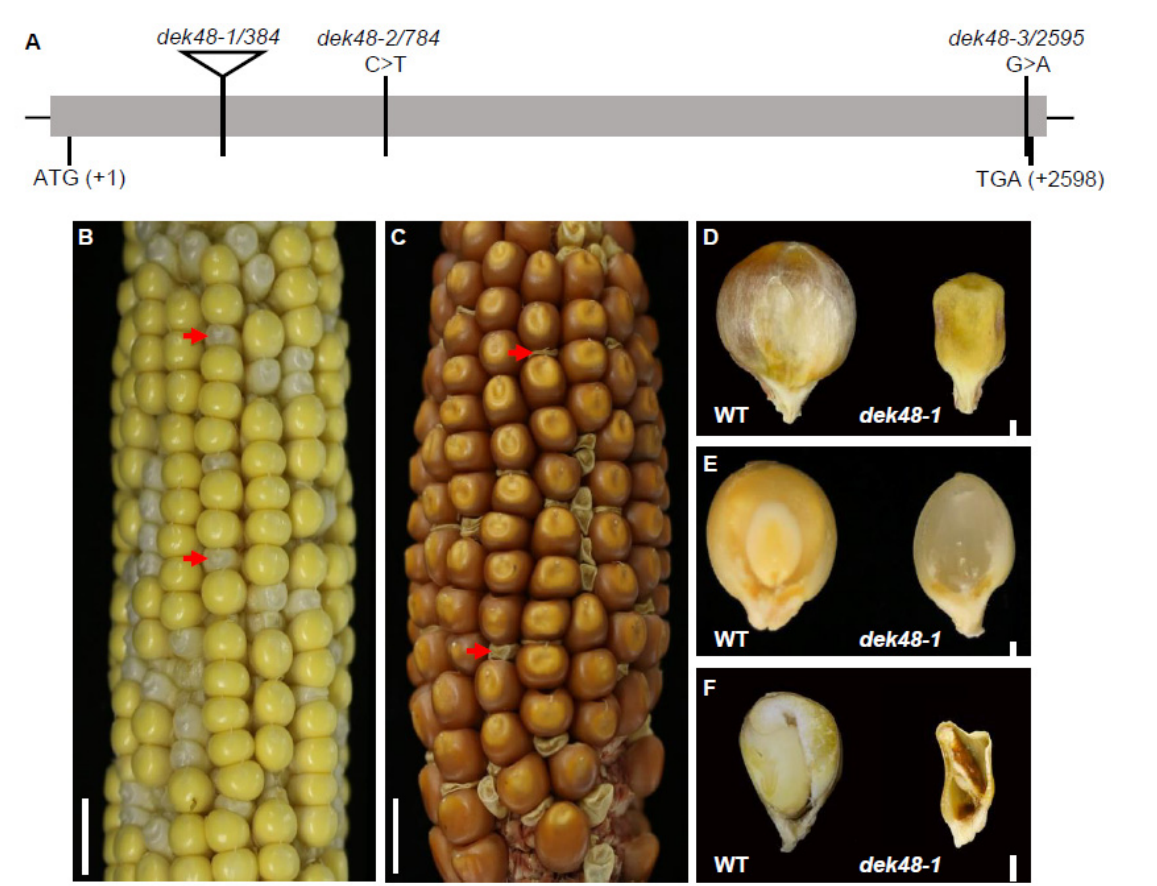
Figure 2. Phenotypic characterization of dek48-1 kernels. ( A ) Schematic structure of the Dek48 gene and positions of Mutator ( Mu ) insertions. The Mu insertion site of dek48-1 and point mutation sites of dek48-2 and dek48-3 are shown in detail. ( B ) A segregating ear of dek48-1 /+ maize at 12 days after pollination (DAP). Arrows point to dek48-1 mutant kernels. ( C ) Mature ear of self-pollinated dek48-1 heterozygotes. Arrows point to dek48-1 mutant kernels. ( D ) Embryo side of mature kernels of wild- type (WT) and dek48-1 kernels. ( E ) The embryo and endosperm of WT and dek48-1 kernels at 12 DAP. (F) Dissection of mature WT and dek48-1 kernels along the embryo axis. Scale bars = 1 cm in ( B , C ); 1 mm in ( D – F ).